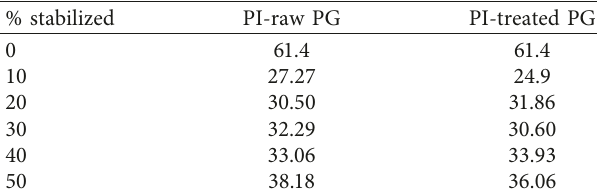
Table 5: PI of stabilized